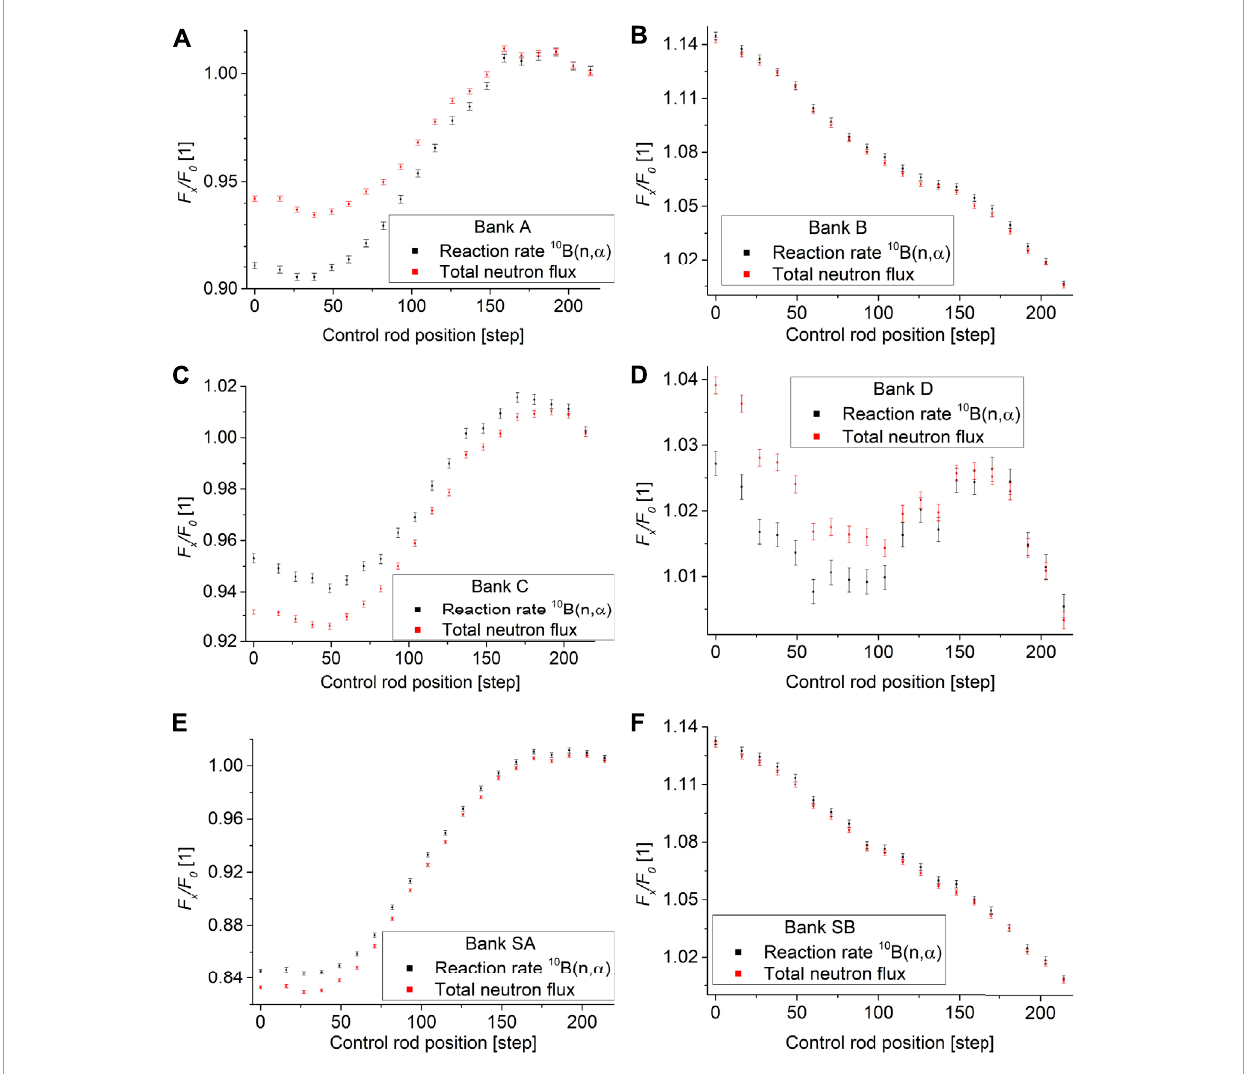
FIGURE 11 Reaction rate redistribution factors (black) and neutron flux redistribution factors (red) for individual control rod bank in multiple steps. (A) A bank. (B) B bank. (C) C bank. (D) D bank. (E) SA bank. (F) SB